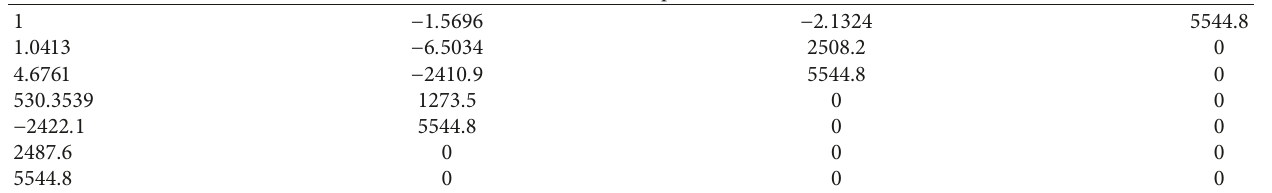
Table 2: Ruth’s Table with parameter